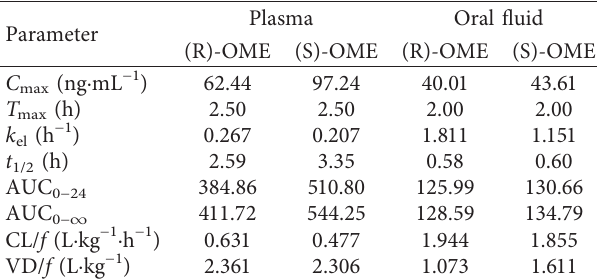
Table 4: Main pharmacokinetic parameters of OME enantiomers in plasma and oral fluid following single oral dose of 20mg to healthy volunteers ( n �